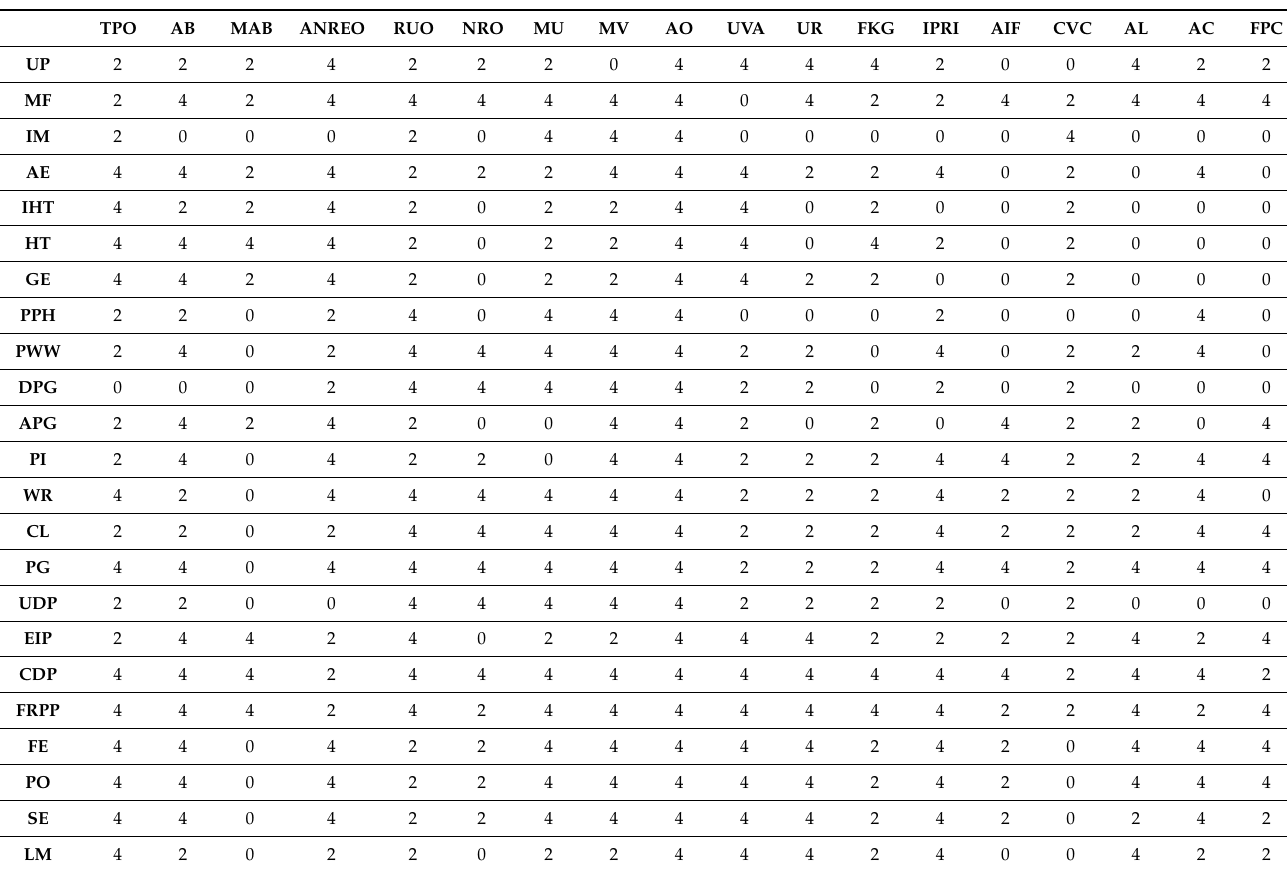
Table A4. Second part of the matrix table of the quantification of relationships among actants involved in the transition.